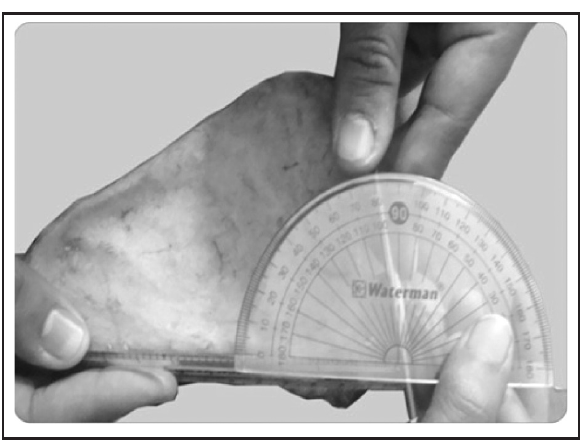
Figure 6. Measurement of Acromion Angle. 6. Coracoid angle: It was measured with the help of protractor as the angle formed where the root of the coracoid process is bent sharply so as to project forward and slightly laterally. 2 For measuring this angle a scale was kept along the lateral border of the coracoid process and another scale was kept along the root of the coracoid process. The angle between the two scales was measured with the help of a protractor (Figure 7).